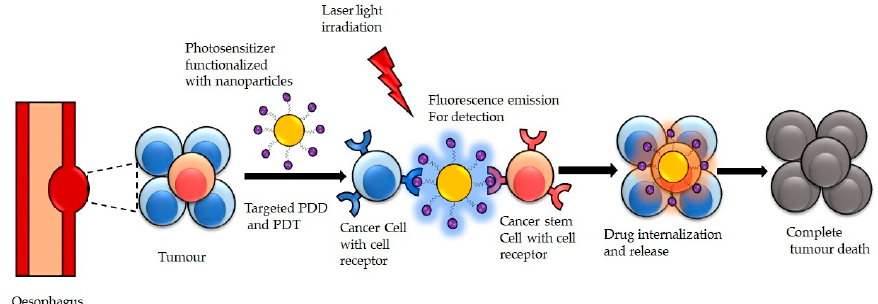
Figure 2. Nanoparticle interaction at the intracellular level facilitates cancer visualization, PS drug internalization, and tumor death.